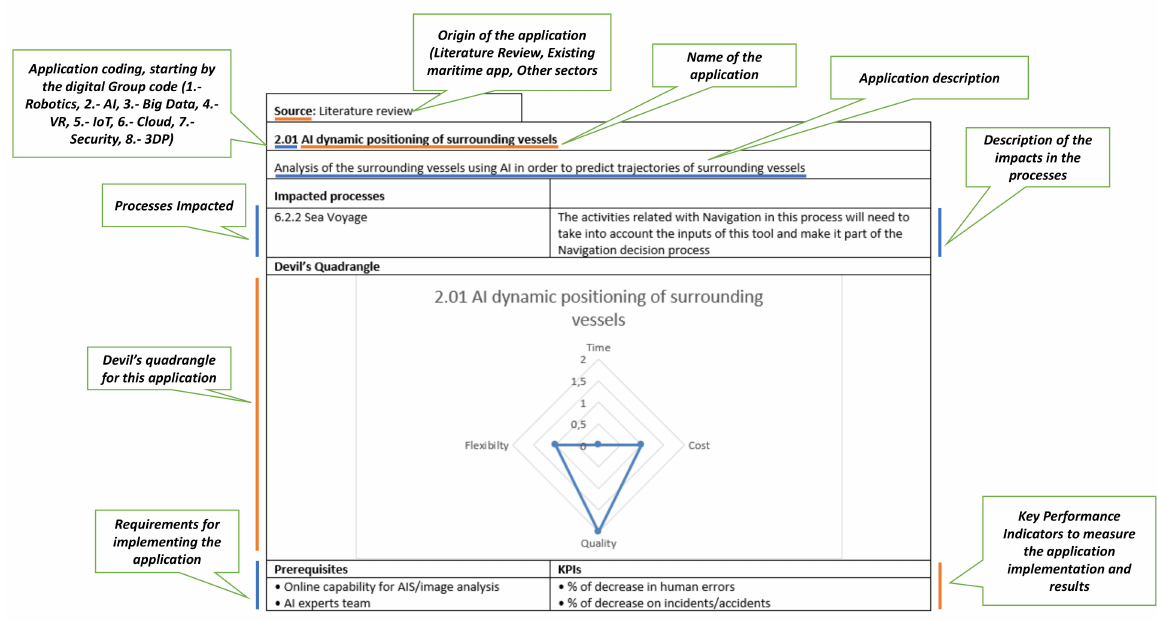
Figure 2. Application data sheet